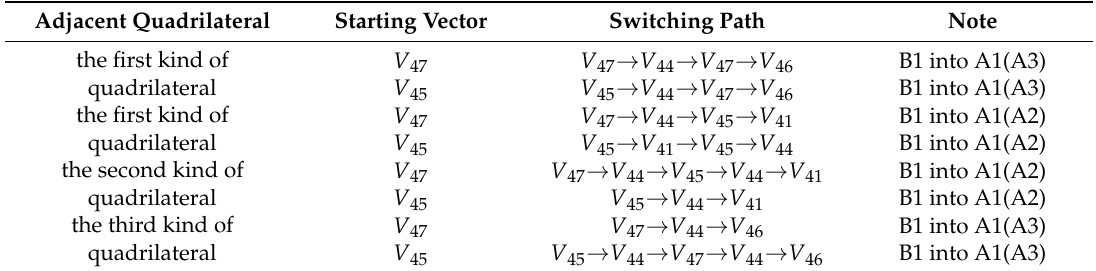
Table 2. Feasible switching paths between the first kind and other kinds of quadrilaterals. Adjacent Quadrilateral